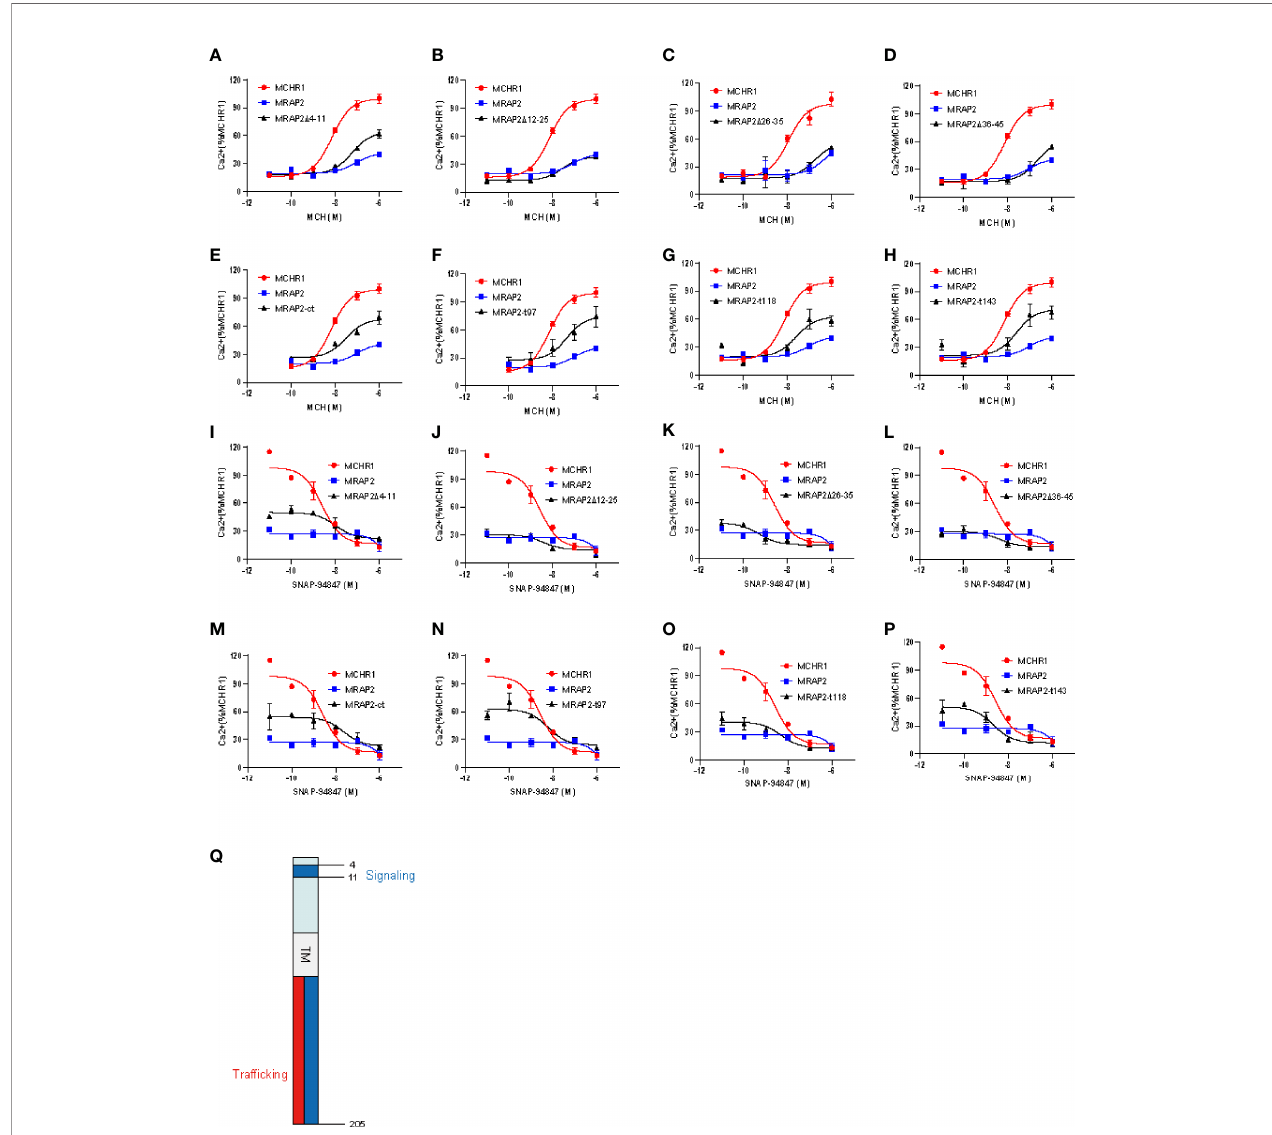
FIGURE 6 | The in fl uence of MCHR1 signaling by the functional domains of MRAP2. (A – H) Calcium response of MCHR1 simulated by increasing concentrations of MCH, transfected with WT MRAP2 or indicated mutants. (I – P) Competition binding assay of MCHR1 in 293T cells transfected with wt MRAP2 or indicated mutants. Relative luminescence intensity of NFAT-luc represents the normalized NFAT-luc units to p-RL-TK units (transfected internal control). Each data point represents the mean±SEM of three replicates ( N =3). (Q) Schematic diagram of distinct regions of MRAP2 required for regulating the traf fi cking and signaling of